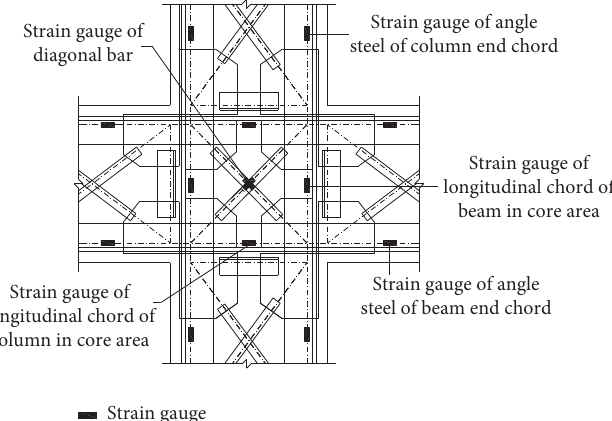
Figure 2: Arrangement of strain measuring